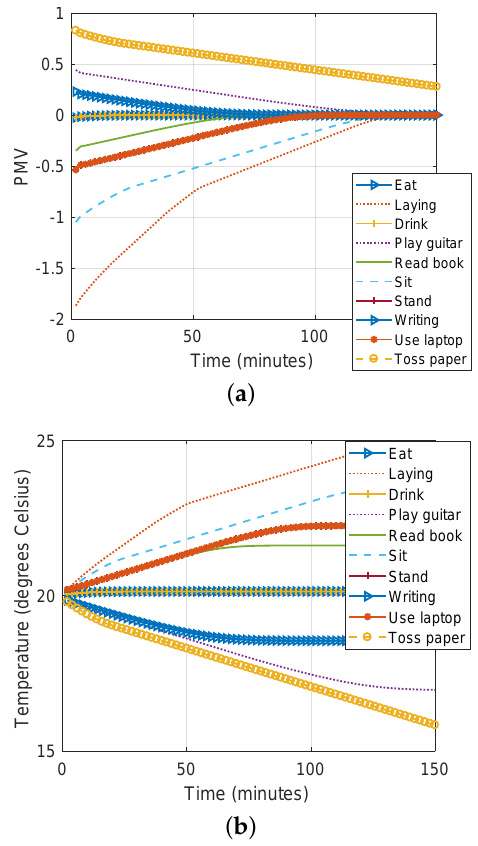
Figure 3. ( a ) PMV thermal comfort index and ( b ) Temperature convergence for different actions based on Fuzzy temperature control started at 20